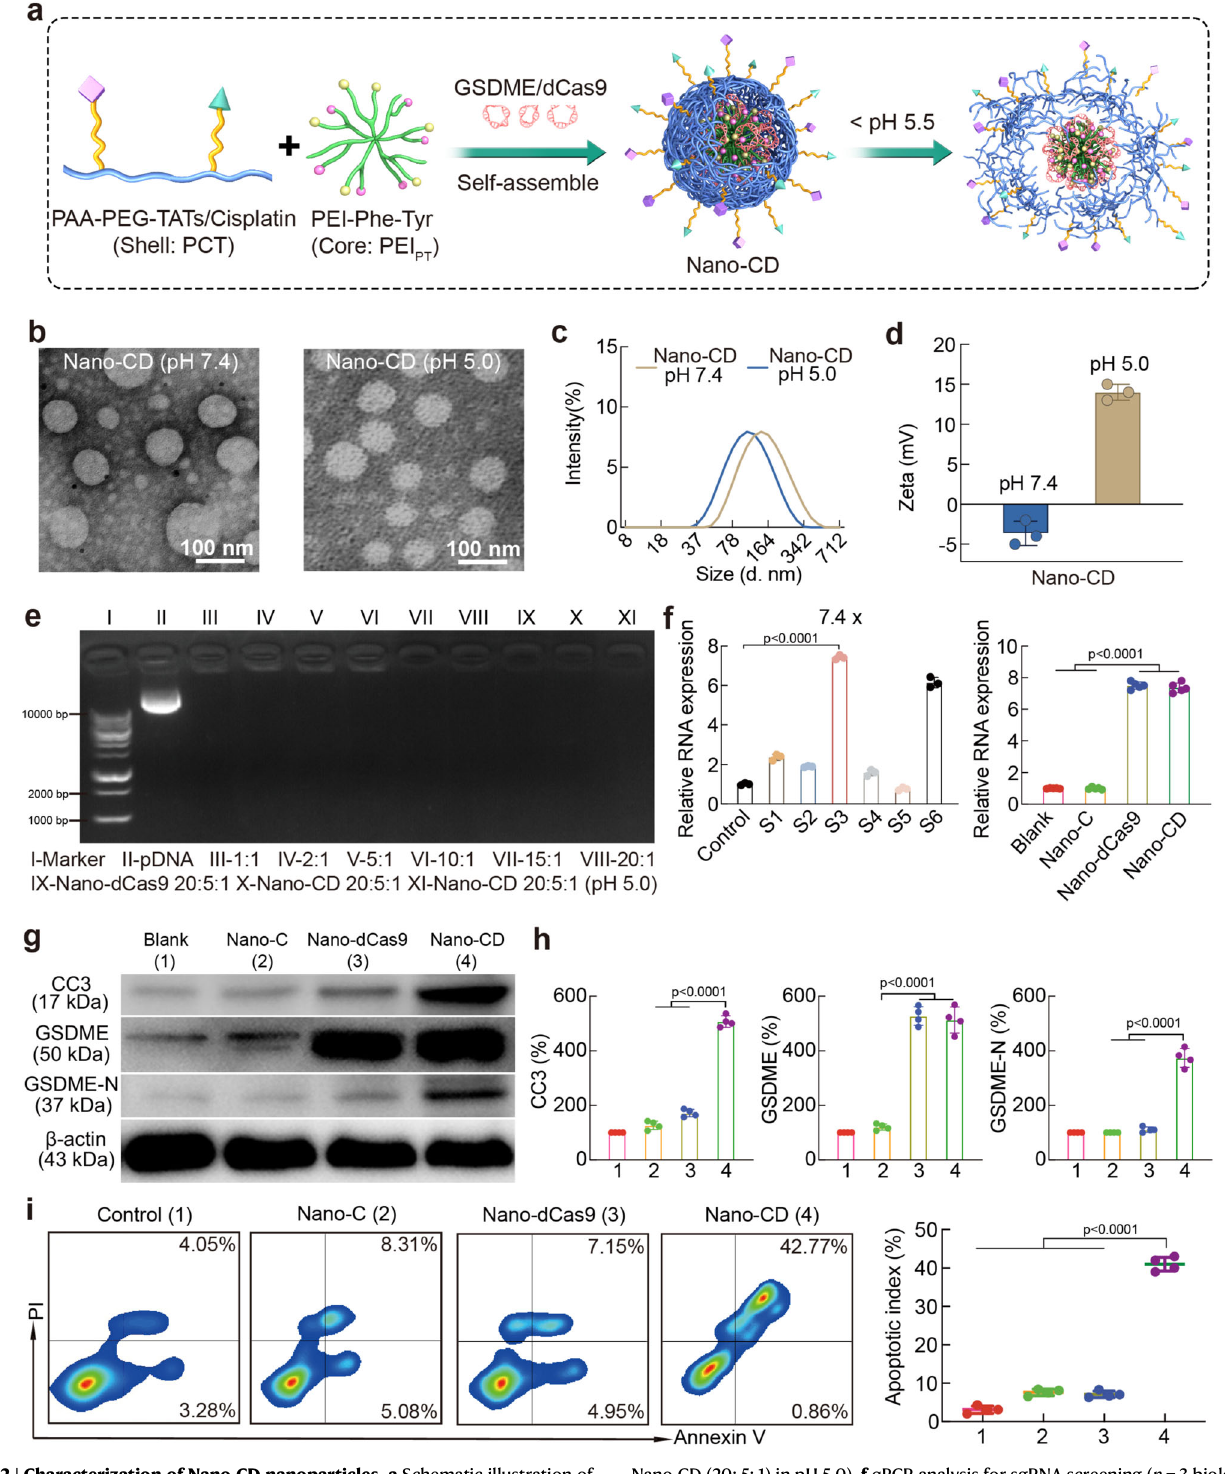
Nano-CD (20: 5: 1) in pH 5.0). f qPCR analysis for sgRNA screening ( n =3 biological replicatespergroup)andGSDMEexpression(n=5biologicalreplicatespergroup). g , h CC3, GSDME, GSDME-N, β -actin expression with different treatments by Western Blots assay. i FCM assay of apoptosis by Annexin V/PI staining ( n =4 bio- logical replicates per group). In panels f , h and i , data are presented as the mean ± s.d. and statistically analyzed using one-way ANOVA and Tukey ’ s